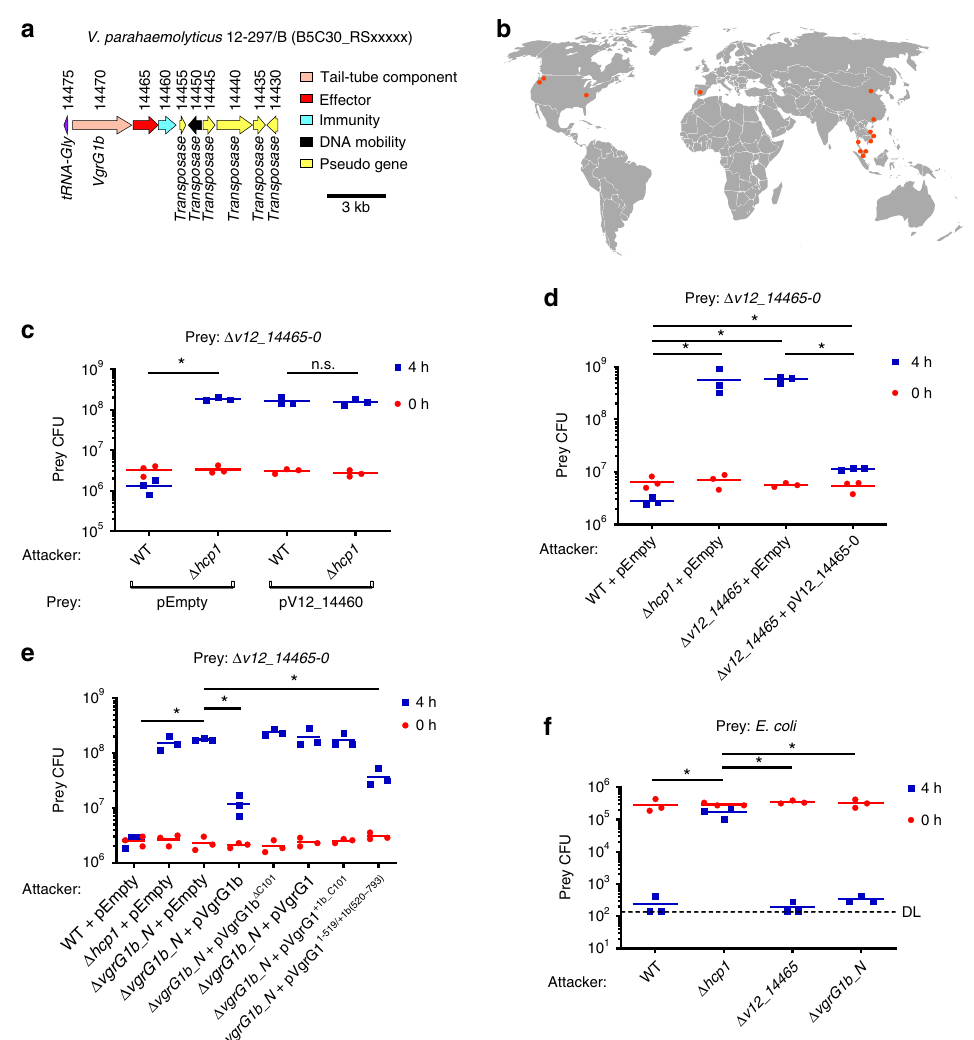
Fig. 1 An auxiliary T6SS1 module in V. parahaemolyticus 12-297/B. a T6SS1 VgrG1b auxiliary module. Genes are represented by arrows indicating the direction of translation. Locus tags (B5C30_RSxxxx) are shown above. b Locations in which the V. parahaemolyticus isolates containing the VgrG1b module have been isolated are denoted by red circles. Viability counts of V. parahaemolyticus 12-297/B ( c – e ) or E. coli ( f ) prey before (0 h) and after (4 h) co- incubation with the indicated V. parahaemolyticus 12-297/B attackers on media containing 3% NaCl at 30 °C. L -Arabinose was added (0.1% in c , 0.01% in e ) to induce expression from the Pbad promoter. Δ hcp1 is used as T6SS1 − control. Asterisks denote statistical signi fi cance between samples at the 4 h timepoint by unpaired, two-tailed Student ’ s t test (* P < 0.05); n.s. no signi fi cant difference, WT wild-type, DL detection limit. Source data are provided as